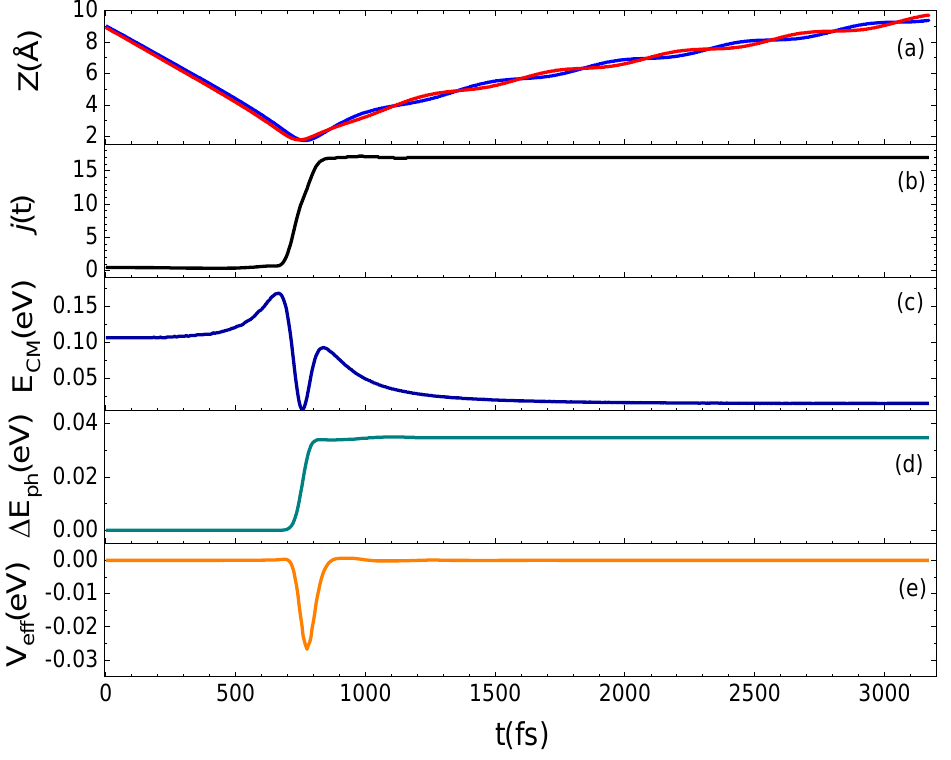
Figure 7. Trajectory for N 2 (0,0) at E coll = 0.5 eV backscattered in the gas-phase as N 2 (0,17). ( a ): De- pendence on the time t of the Z coordinate, for the two atoms (identified by red and blue lines) in the N 2 molecule; ( b ): rotational state evolution along the trajectory; ( c ): variation of the CM translational energy; ( d ): energy exchanged with the surface phonons; ( e ): V eff potential.